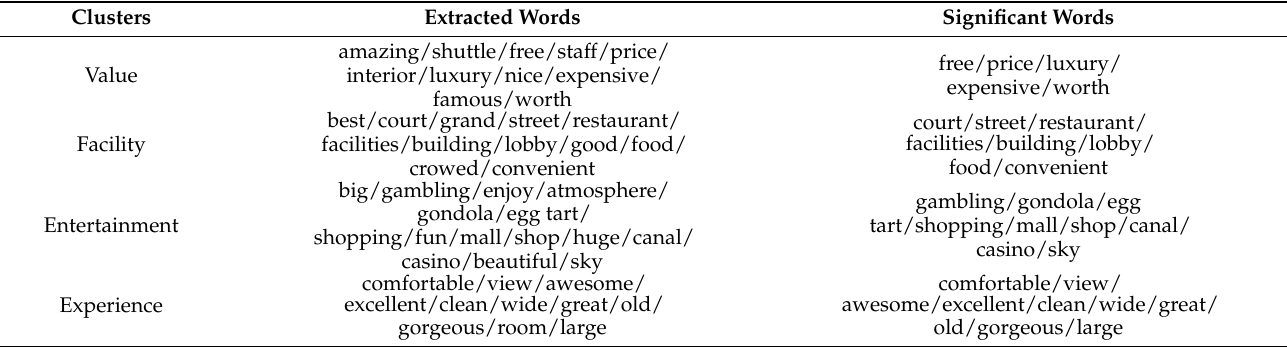
Table 5. Result of CONCOR analysis